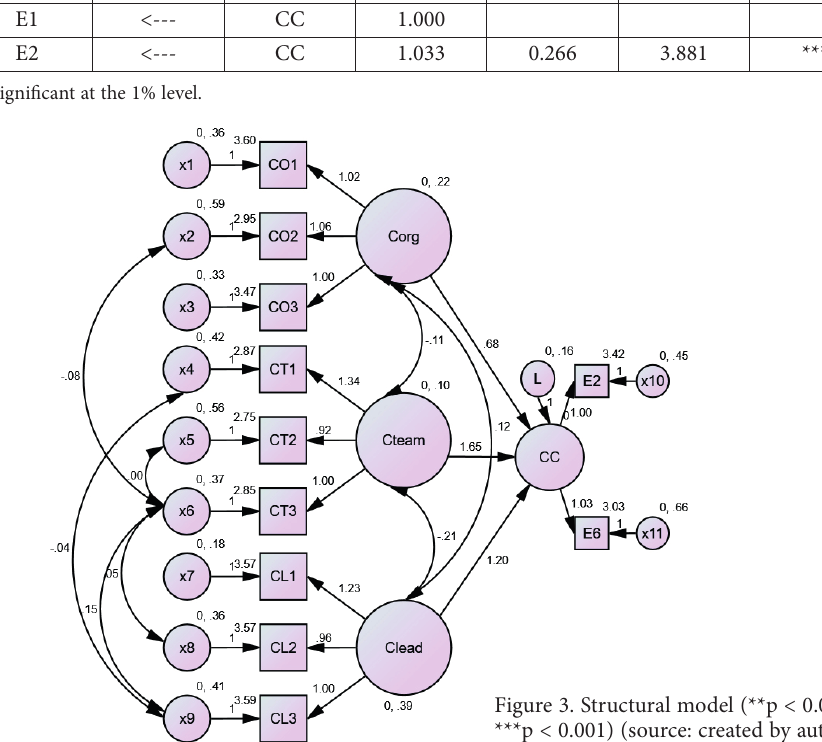
Figure 3. Structural model (**p < 0.01; ***p < 0.001) (source: created by